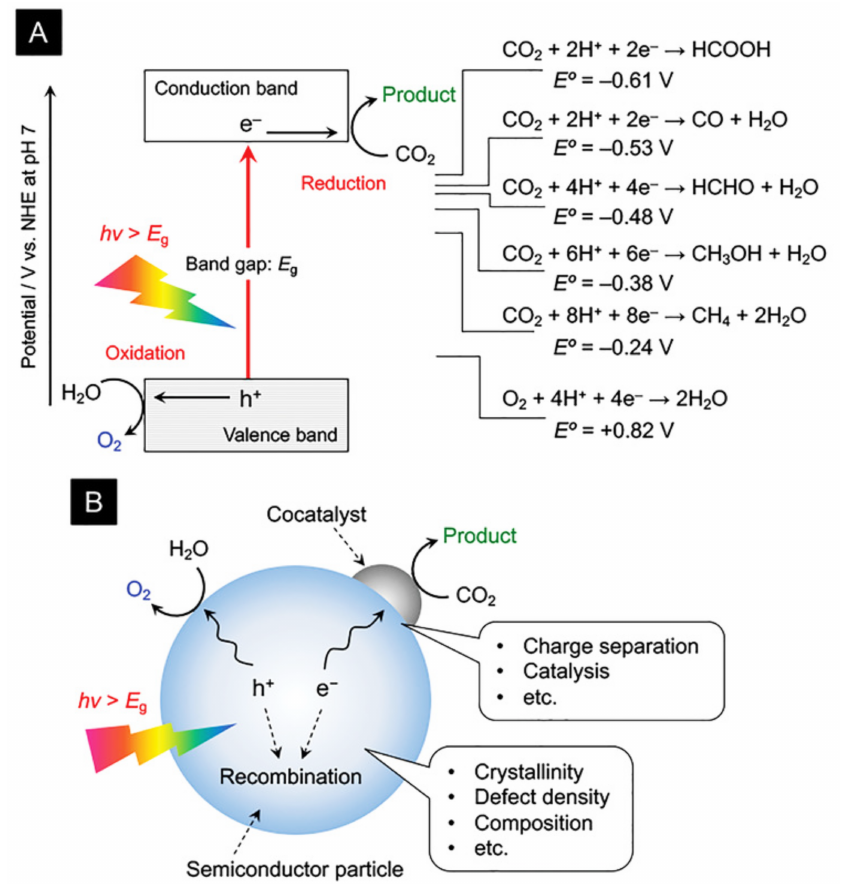
Figure 7. ( A ) Schematic energy diagram for CO 2 reduction and ( B ) H 2 O oxidation over 2D photocat- alysts. Adapted from [105] Copyright 2019 Wiley.